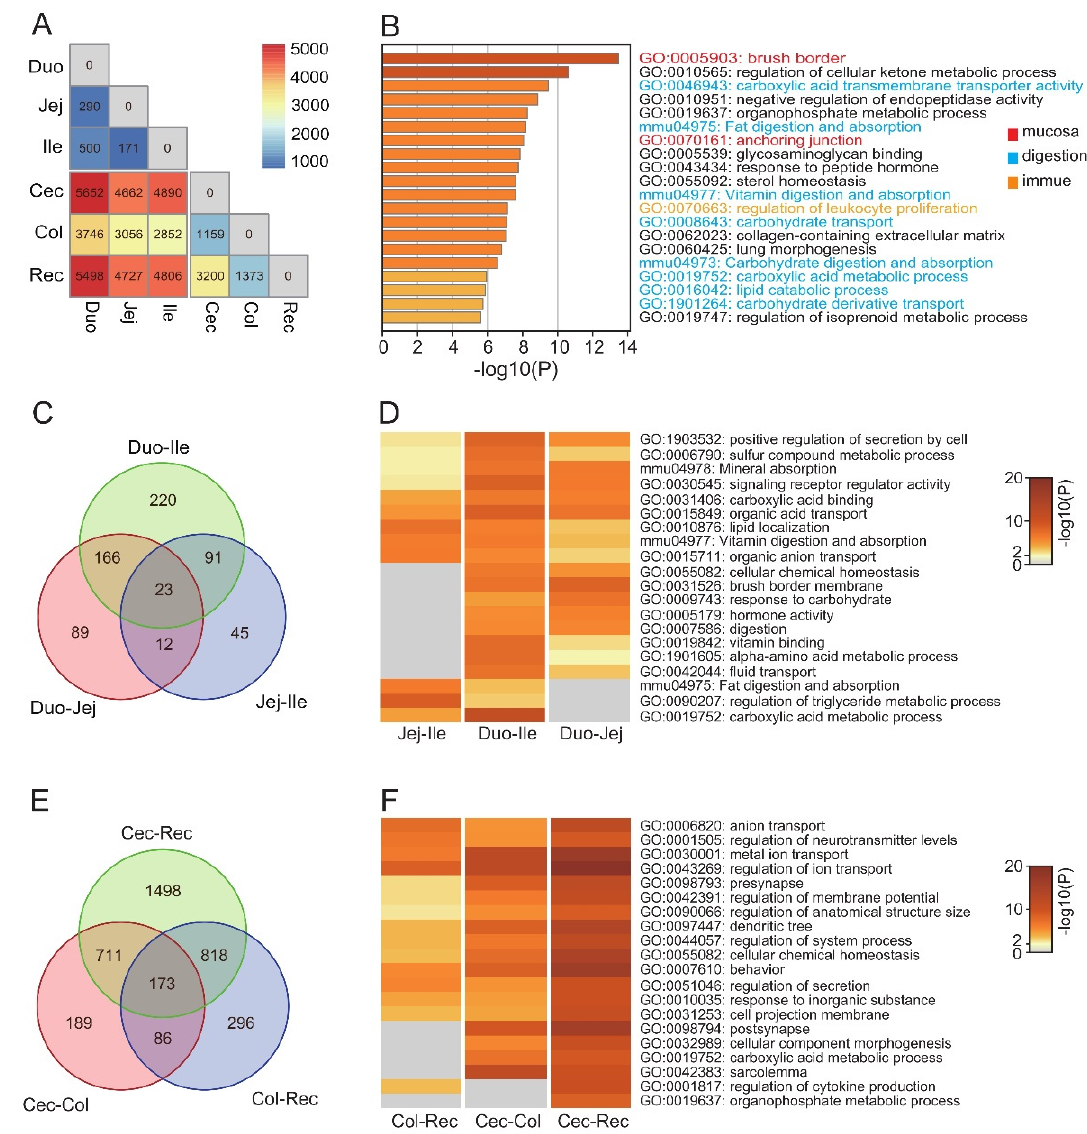
Figure 2. Differential gene analysis between intestinal segments. ( A ) Number of DEGs between paired segments; ( B ) Enrichment analysis of DEGs between small intestine and large intestine, showing the top 20 terms sorted by p -value; ( C ) Venn diagrams show the distribution of DEGs in different combinations of small intestine ( D ) and large intestine; ( E ) Enrichment results of DEGs in different combinations of small intestine. Duo: Duodenum; Jej: jejunum; Ile: ileum; Cec: cecum; Col: colon; Rec: rectum.